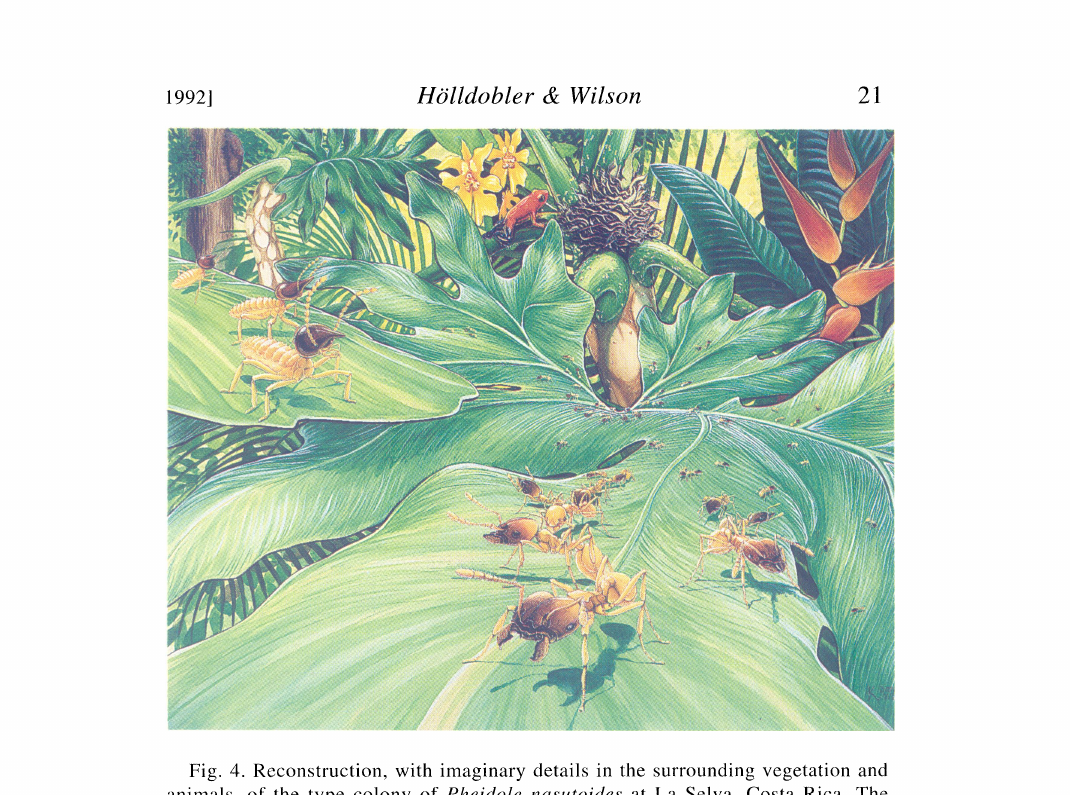
Fig. 4. Reconstruction, with imaginary details in the surrounding vegetation and animals, of the type colony of Pheidole nasutoides at La Selva, Costa Rica. The nest of the ants has been disturbed (in this hypothetical scenario) by a Dendrobates frog, a species known to feed on ants. Both majors and minors swarm out and run swiftly in erratic looping paths over the vegetation. This motion, together with their unique color pattern, causes the large-headed major workers to resemble nasute sol- diers of the termite genus Nasutitermes. Several of the termite soldiers, on a forag- ing expedition, pause on a leaf to the